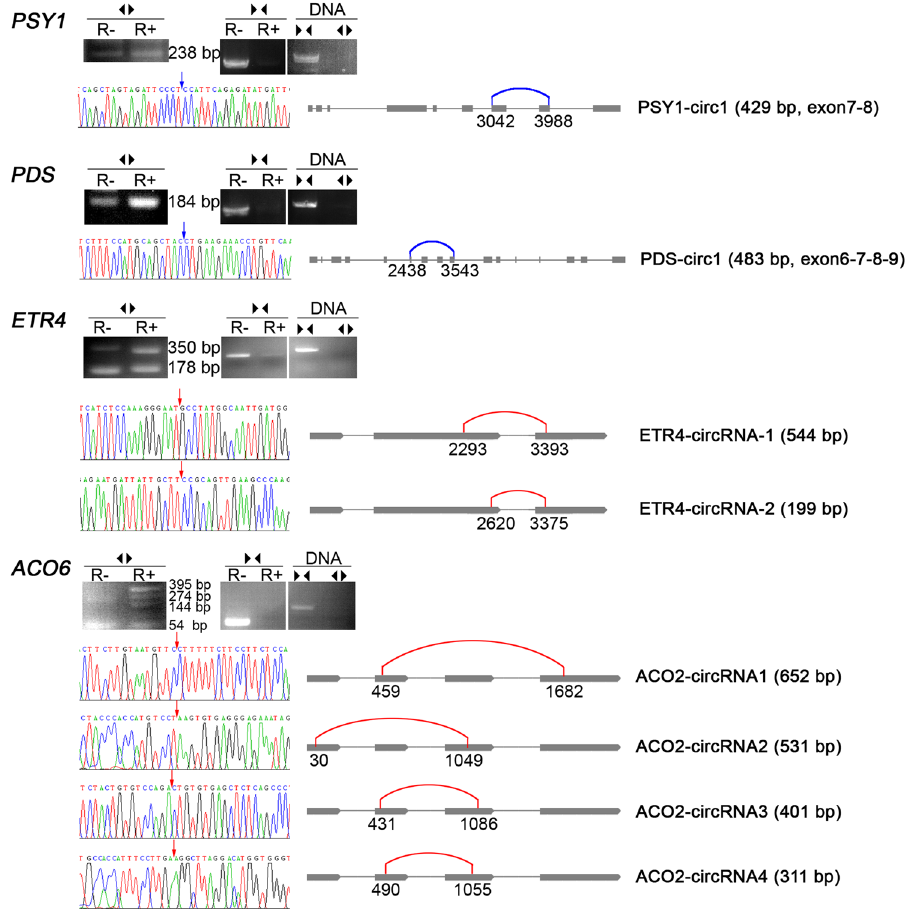
Figure 2. Canonical and non-canonical circRNAs validated by RNase R resistance and sequencing. RNase R resistance analysis. After DNase I treatment, total RNA from tomato fruit pericarp was digested with (R + , one hour at 37 °C) or without (R − , use water instead) RNase R. Both R + and R − were reverse transcribed to cDNA using random primers. Divergent primers (◀▶) and convergent primers (▶◀) were used to identify circRNAs and linear RNAs respectively. Genomic DNA was also used as template to make certain that the site is not existent in genome. Sanger sequencing of divergent primers-amplified products were showed. The blue arrows and blue curves indicate canonical back-splice sites, while the red arrows and red curves indicate non-canonical back-splice